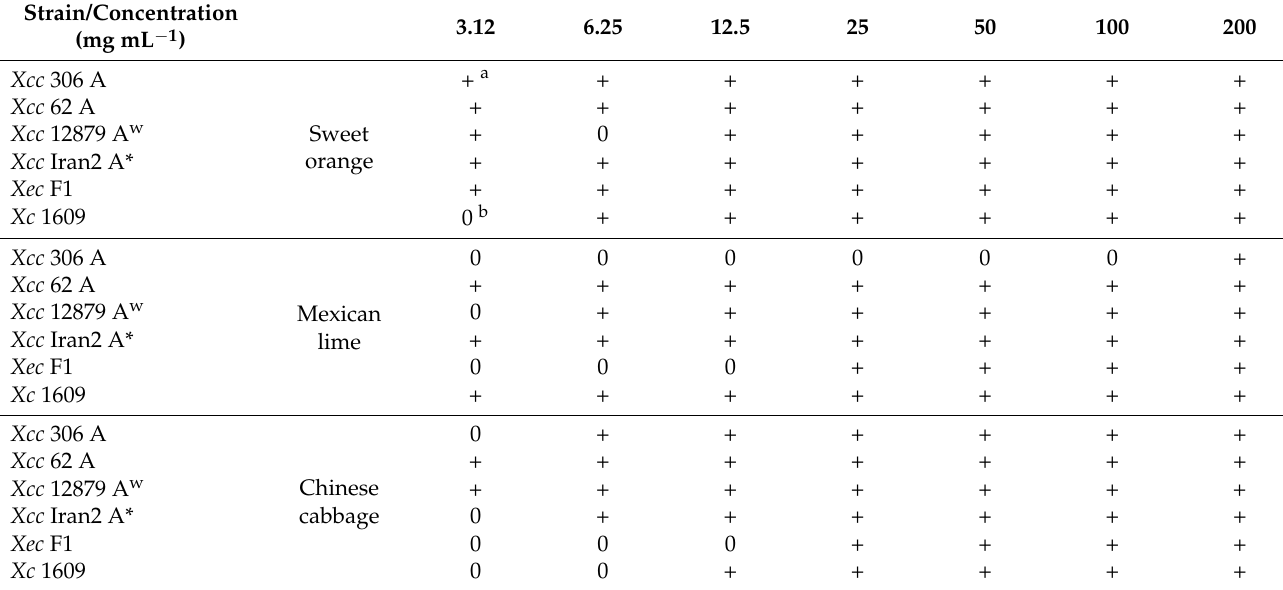
Table 6. Chemotactic responses toward different concentrations of several apoplastic fluids of Xanthomonas pathogenic to citrus and crucifers a